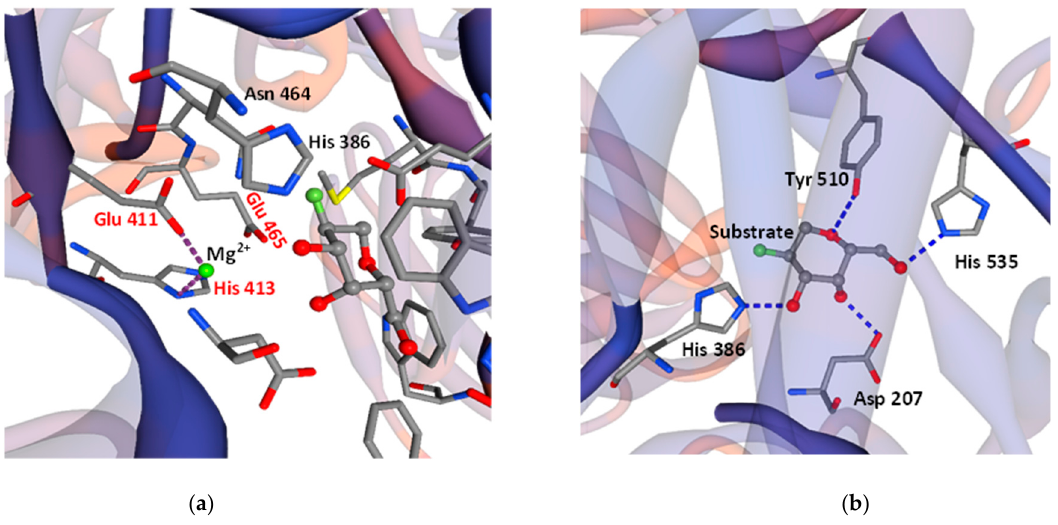
Figure 3. SWISS-MODEL Workspace/GMQE prediction of interactions between amino acids in the active center of β -galactosidase of L. bulgaricus strain 43. ( a ) According to the model, glutamates (Glu 411, Glu 465) and His 413 contact metal cations; ( b ) two histidine residues (His 386, His 535), Asp 207, and Tyr 510 form hydrogen bonds with the substrate as a part of the active center.